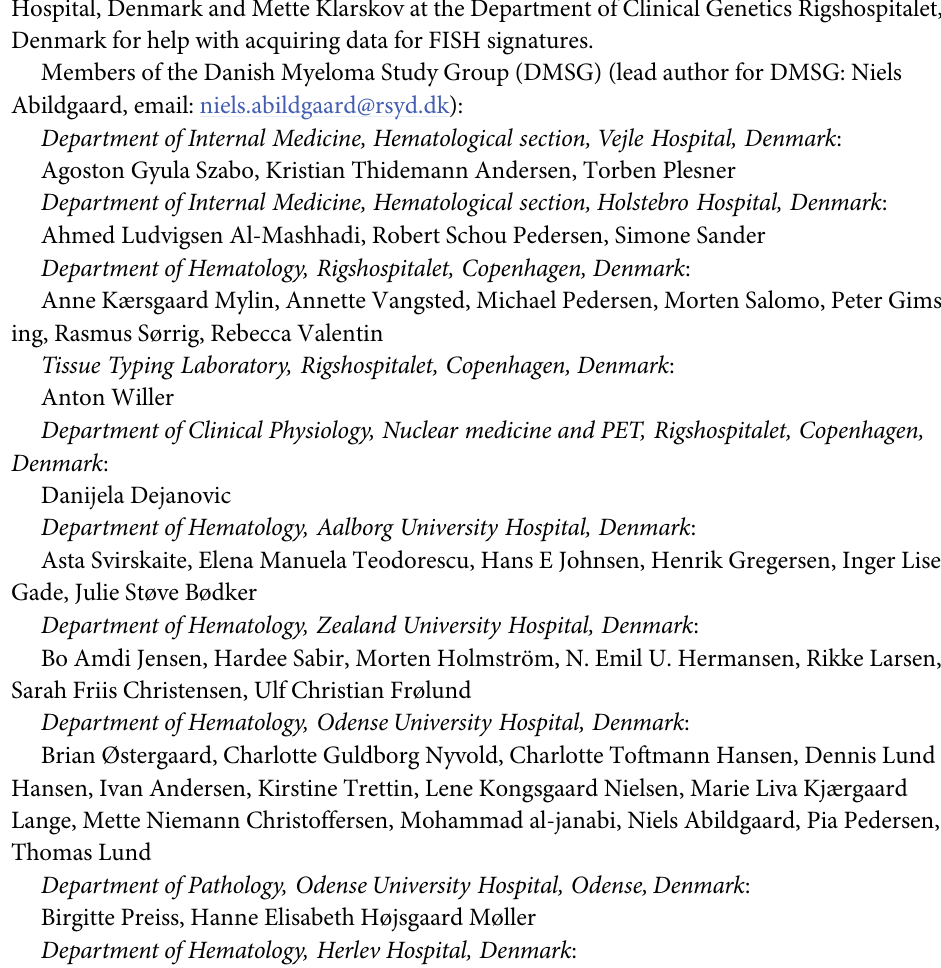
S1 Table. A univariable analysis of potential risk factors for OS and PFS for all patients in the cohort. S2 Table. Multivariable analysis of the effect of immunoparesis in calendar periods 2005– 2008 and 2009–2013 divided by age